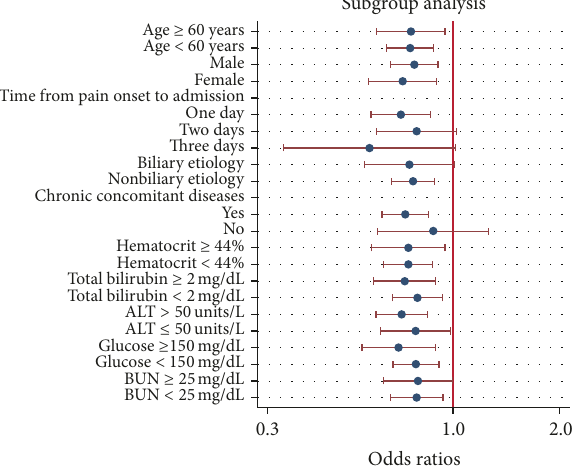
Figure 5: Logistic regression plot of odds ratios and 95% confidence intervals; subgroup analysis of relationship between serum albumin level and mortality in acute